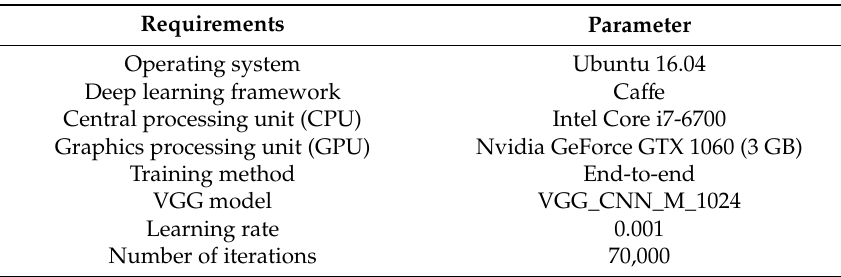
Table 8. Training parameters.